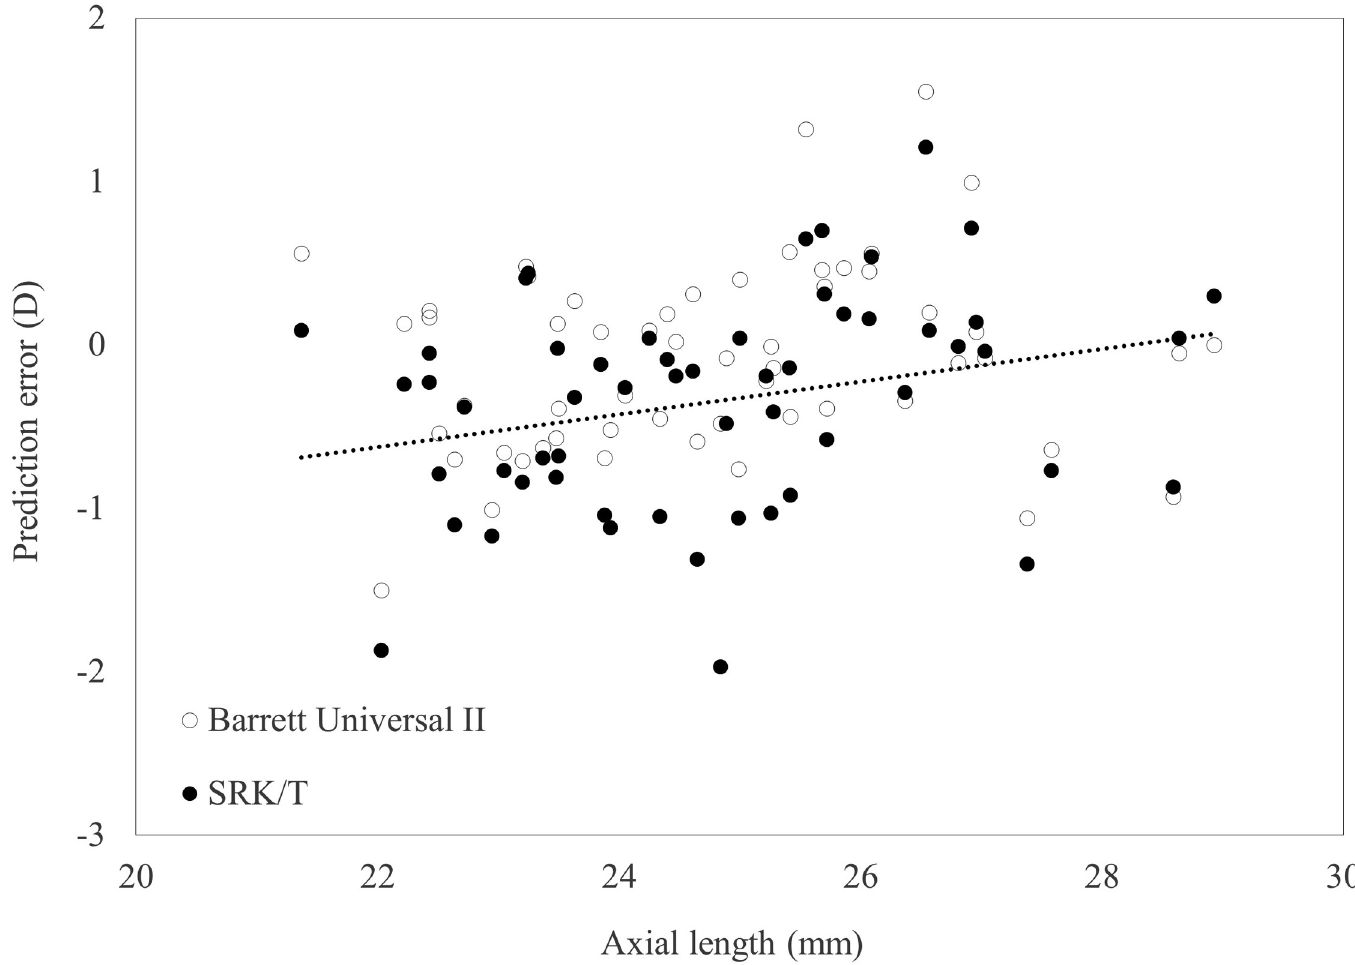
Fig 3. A graph showing correlations between the prediction error and the axial length (Pearson correlation coefficient, r = 0.219, p = 0.167 for the Barrett Universal II formula, r = 0.273, p = 0.042 for the SRK/T formula).